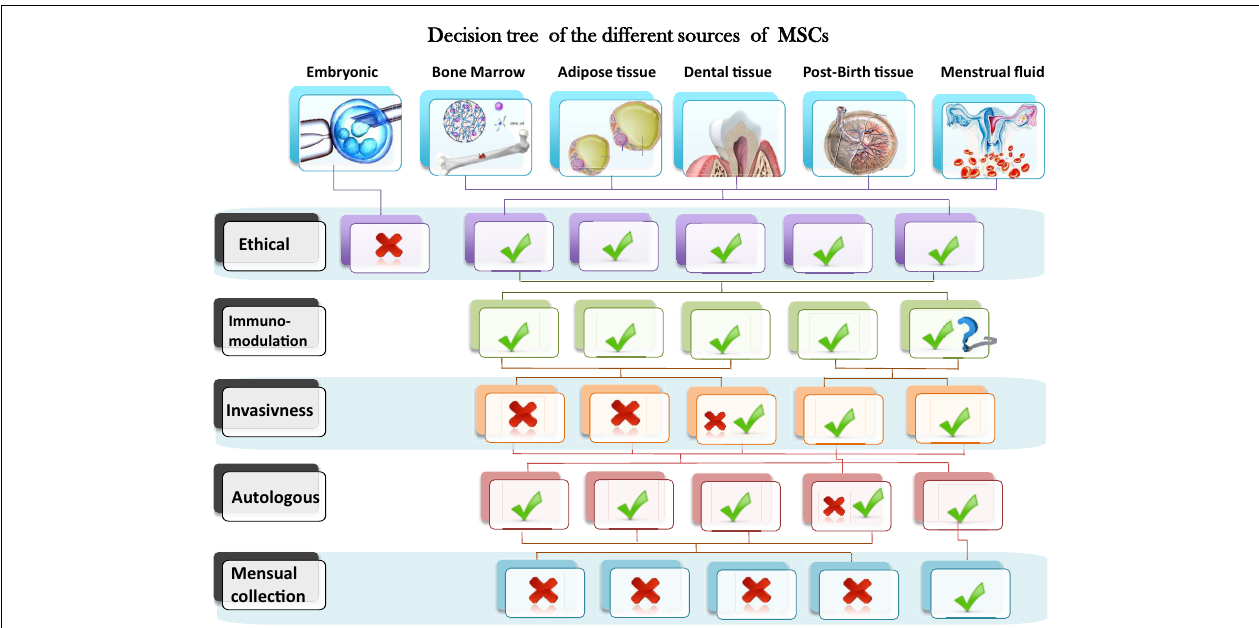
FIGURE 1 | Schematic representation of a decision tree based on six sources of MSCs and five different criteria related to their availability, isolation procedure and different properties .